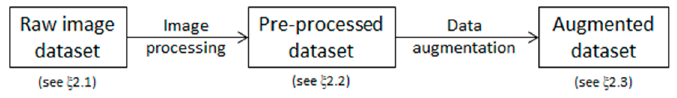
Figure 1. Block diagram for the generation of an augmented pre-processed dataset.